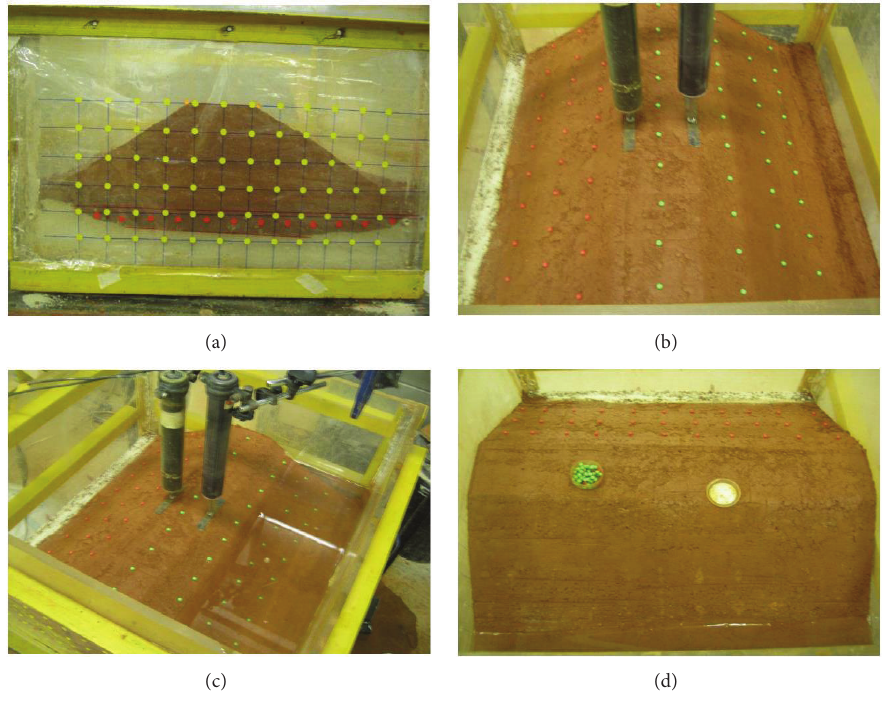
Figure 24: Dam stabilization in the fifth model (Model